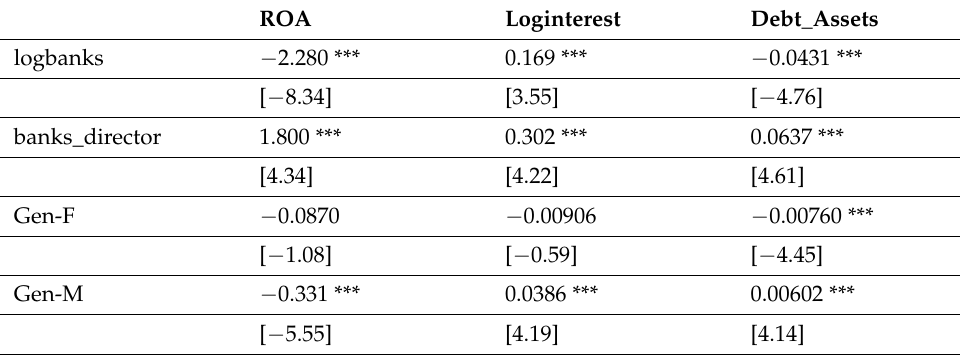
Table 4. Results of determination of ROA (performance), cost of debt, and debt-to-assets (leverage) for all